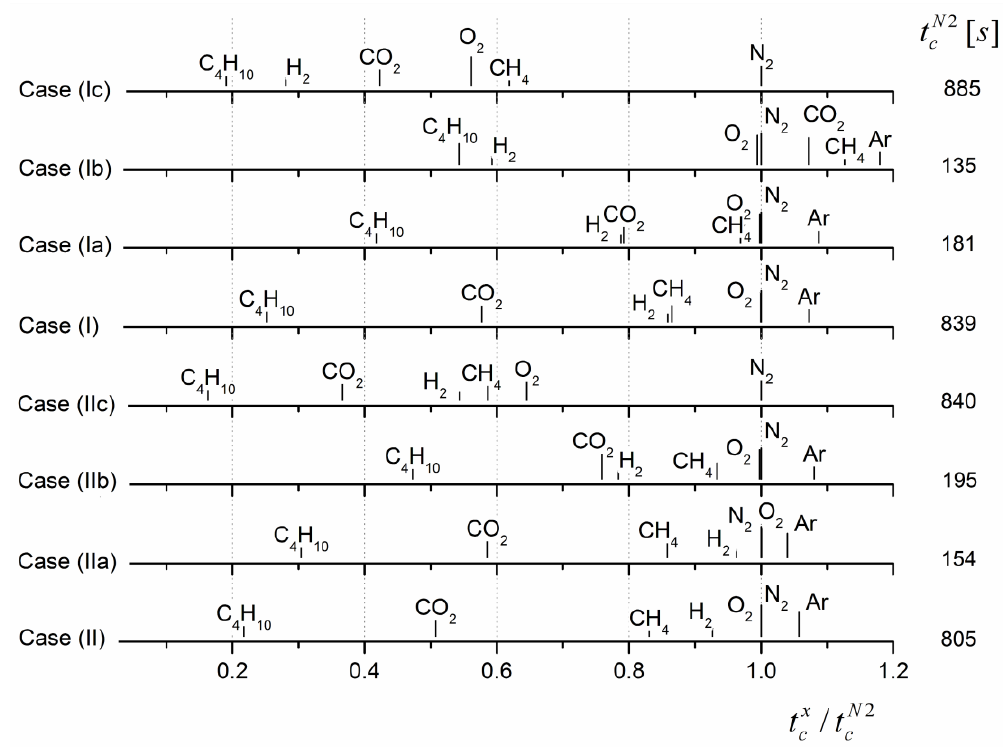
Figure 9. Critical times for the identification of the indicated added gas component depending on: the operating mode, cases (I) and (II); cell configuration; and composition of gas matrix. The simulation parameters are listed in Table 5. The critical times of N were used to normalize the case-dependent time bases. Corresponding absolute 2 N are displayed on the right.